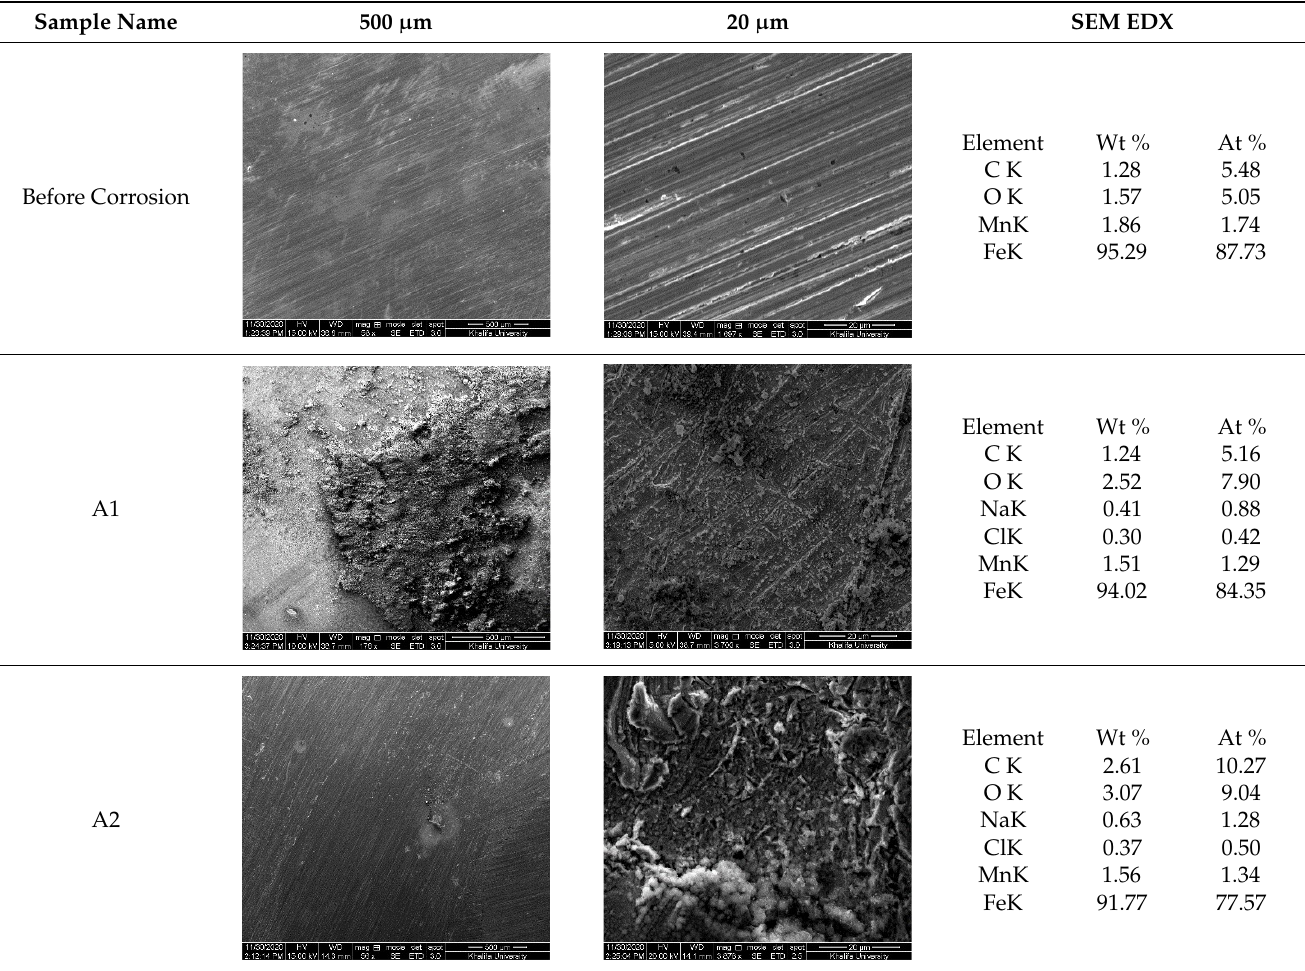
Table 7. SEM Images of API 5L X65 samples.